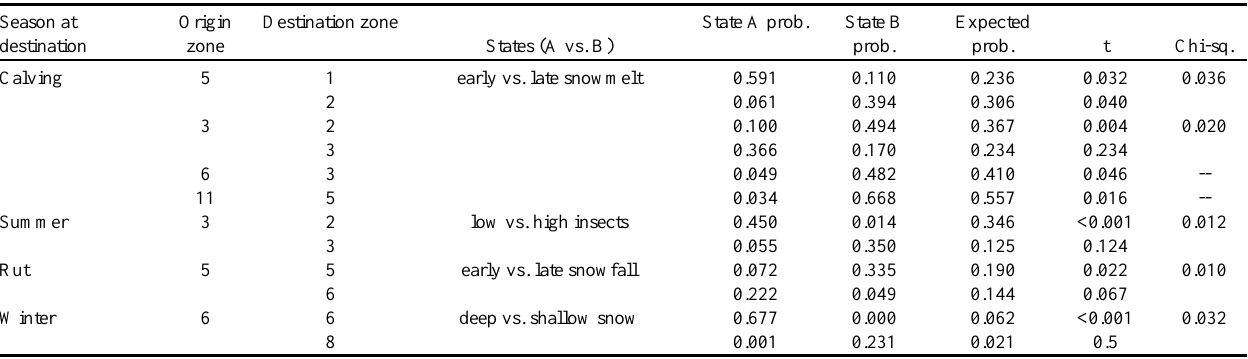
Table 4 . Seasons, origins, and destinations for which environmental conditions significantly affected caribou movements: actual vs. expected probabilities of moving given previous season origin, with test probabilities for difference of means (t) and actual vs. expected for destination pairs